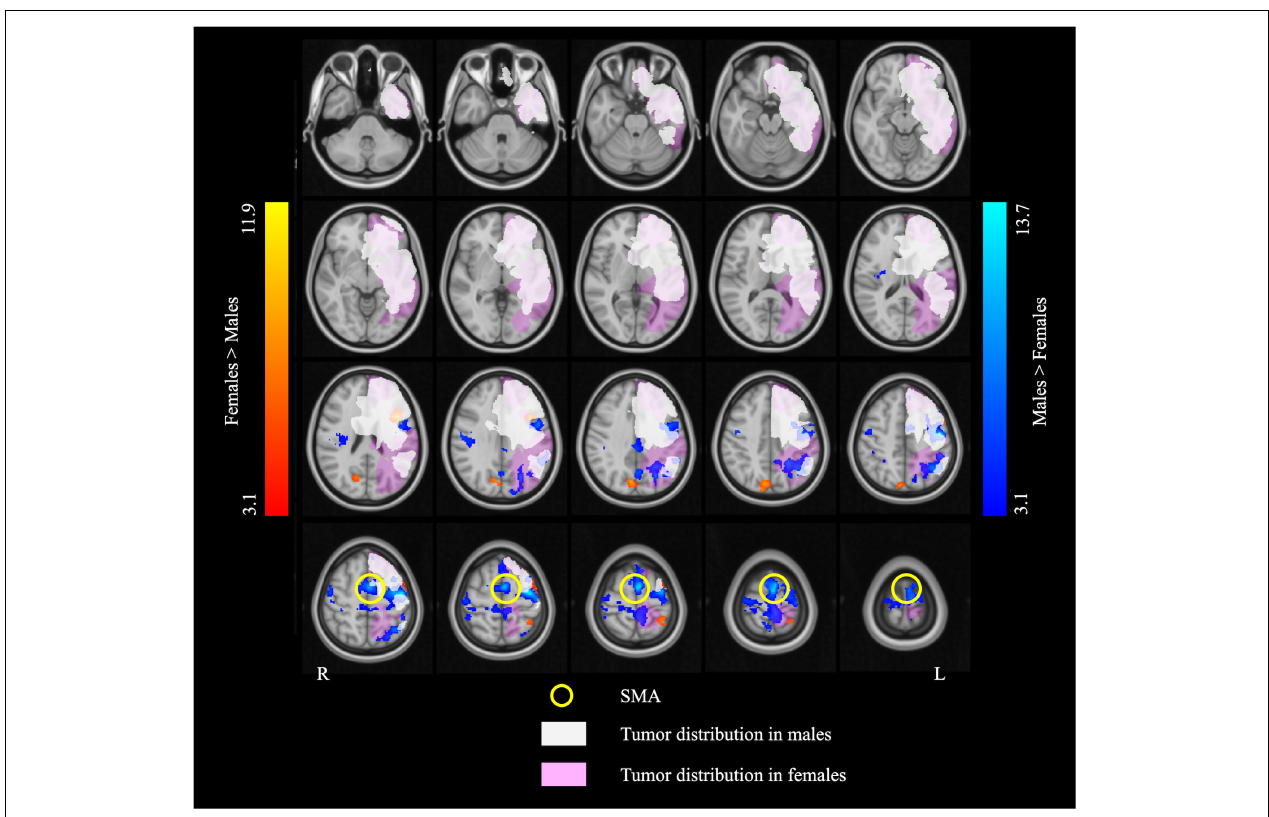
FIGURE 4 | The overlap map of fMRI activation and brain tumor distribution. The white and pink overlays represent the areas affected by brain tumor in the males and the females, respectively. The blue and red overlays represent the fMRI activation in the two language tasks in the males and the females, respectively. Note that the supplementary motor area (SMA) (indicated by the yellow circles) is completely outside of the areas afflicted by tumor in both males and females.